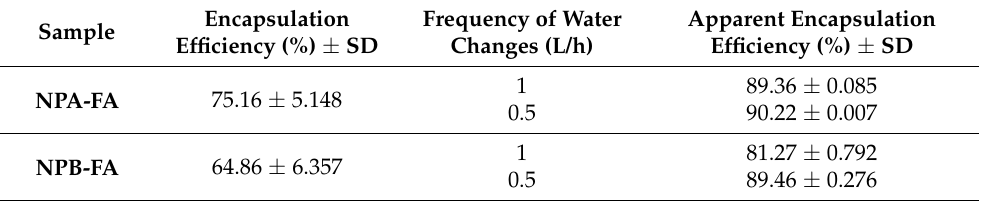
Table 3. Encapsulation efficiency (%) of NPA-FA and NPB-FA and apparent encapsulation effi- ciency (%) of NPA-FA and NPB-FA referred to the purification processes using the dialysis method performed with frequency of water exchanges of 0.5 and 1